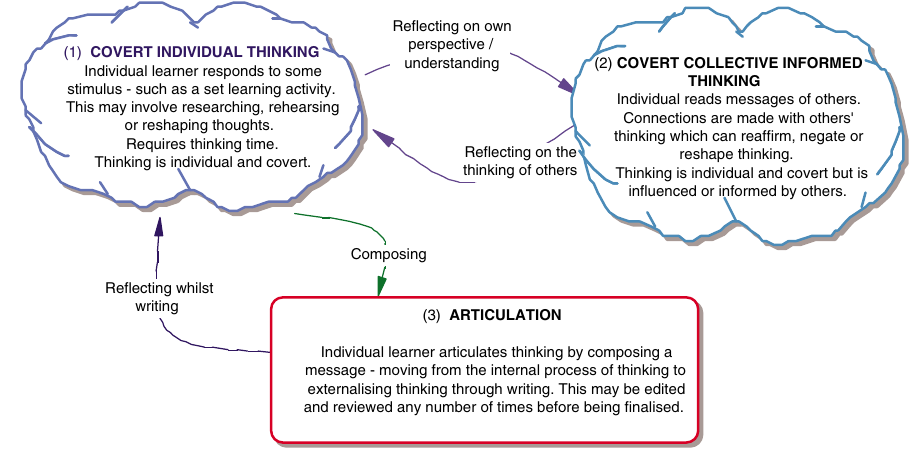
Figure 4. Articulation as a process of learning.